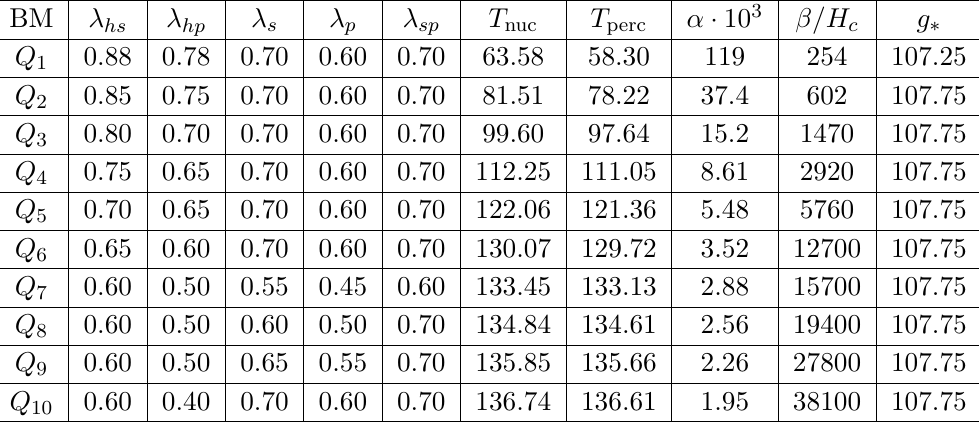
Table 1 . Dimensionless parameters of selected benchmark models (BM) with the first order electroweak phase transition as well as nucleation and percolation temperatures T nuc , T perc (in GeV), strength α , ratio β/H c and effective number of degrees of freedom g ∗